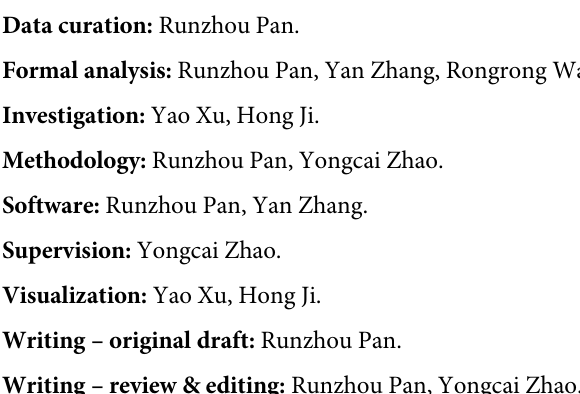
S1 Fig. Risk of bias graph. S2 Fig. Risk of bias summary. S3 Fig. Meta-analysis of FM level comparisons between SGLT-2 inhibitors and the control group based on the control. S4 Fig. Meta-analysis of LM level comparisons between SGLT-2 inhibitors and the control group based on the